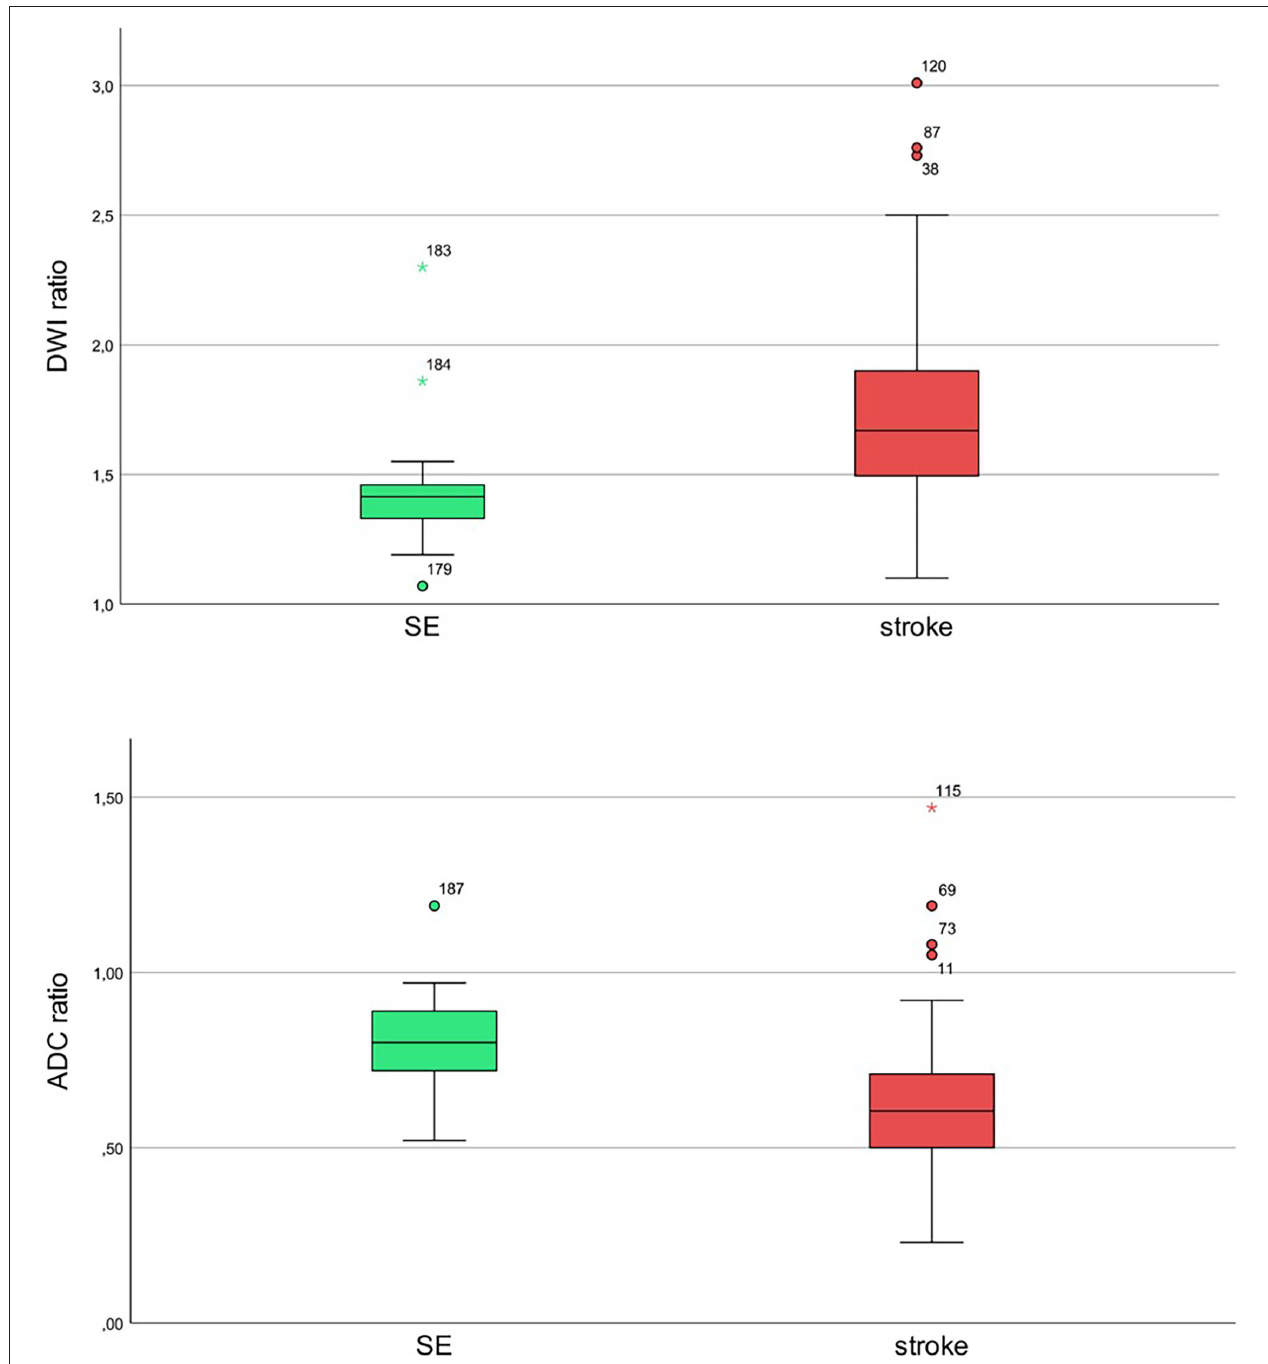
FIGURE 2 | Ratios of diffusion-restricted lesions to mirror the healthy side for status epilepticus (SE; green) and stroke (red) with diffusion-weighted imaging (DWI) hyperintensity and apparent diffusion coefficient (ADC) signal decrease for SE and stroke patients. Upper image: diffusion b-value of 1,000. Lower image: ADC maps.